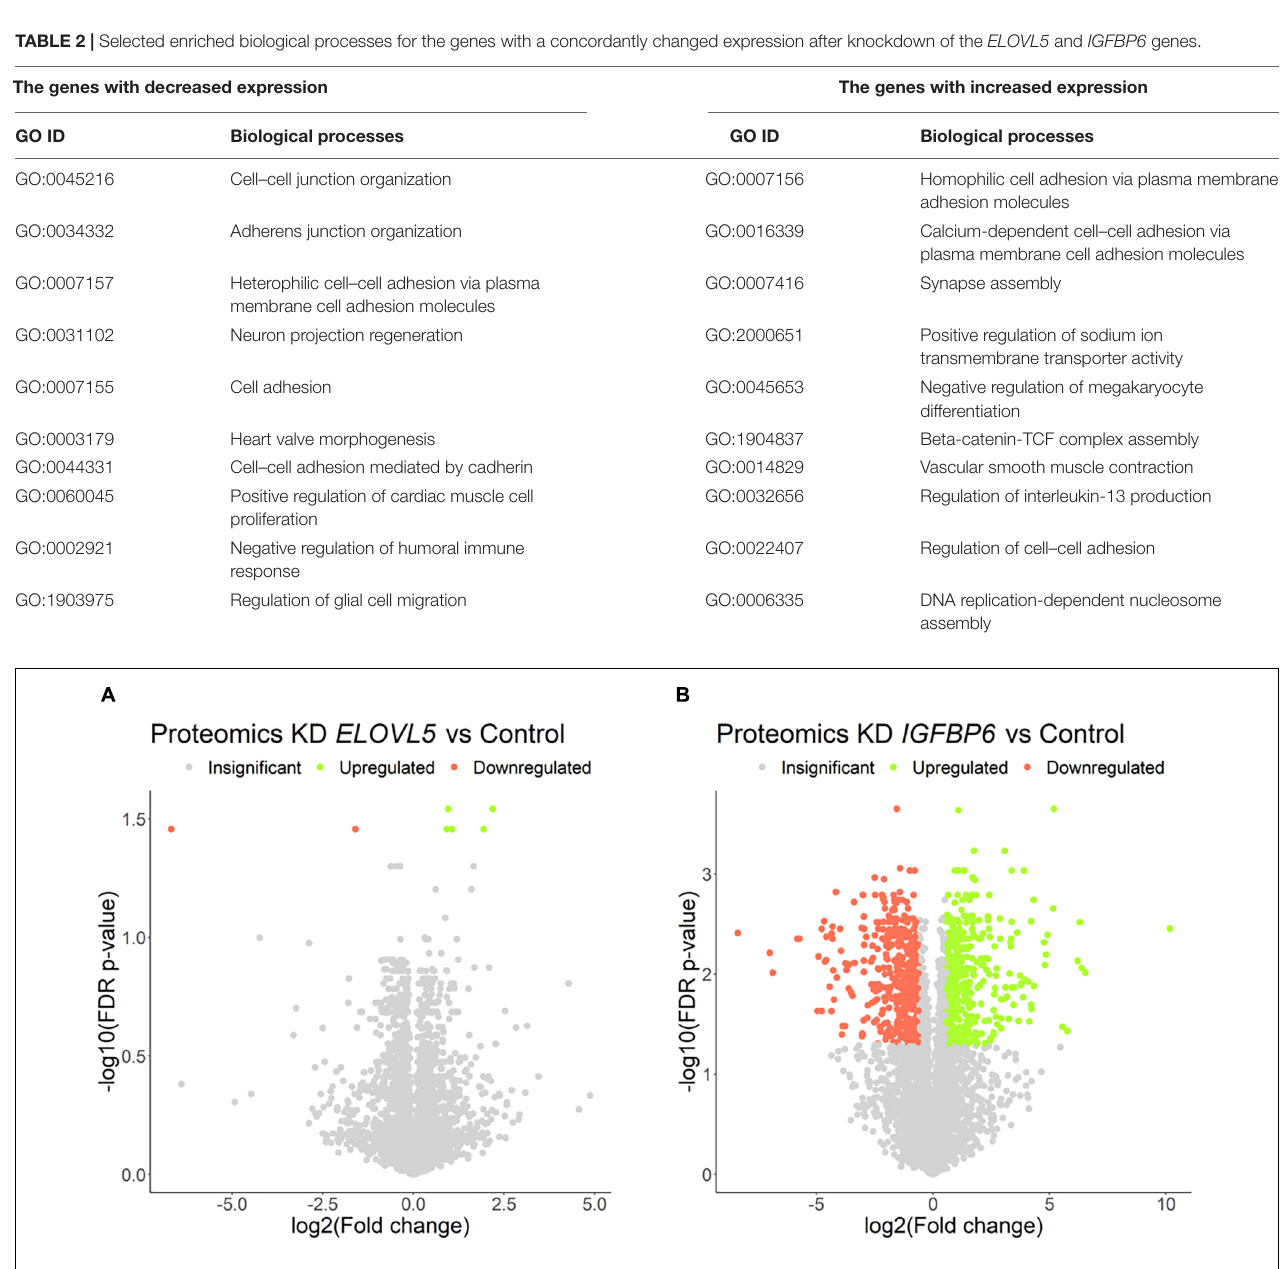
in cell migration and adhesion ( Table 3 and